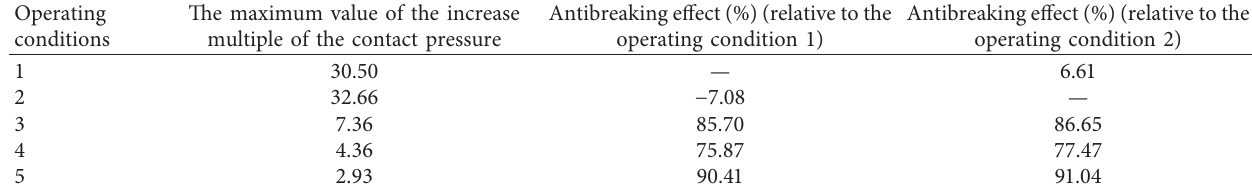
Table 6: Antibreaking effect of contact